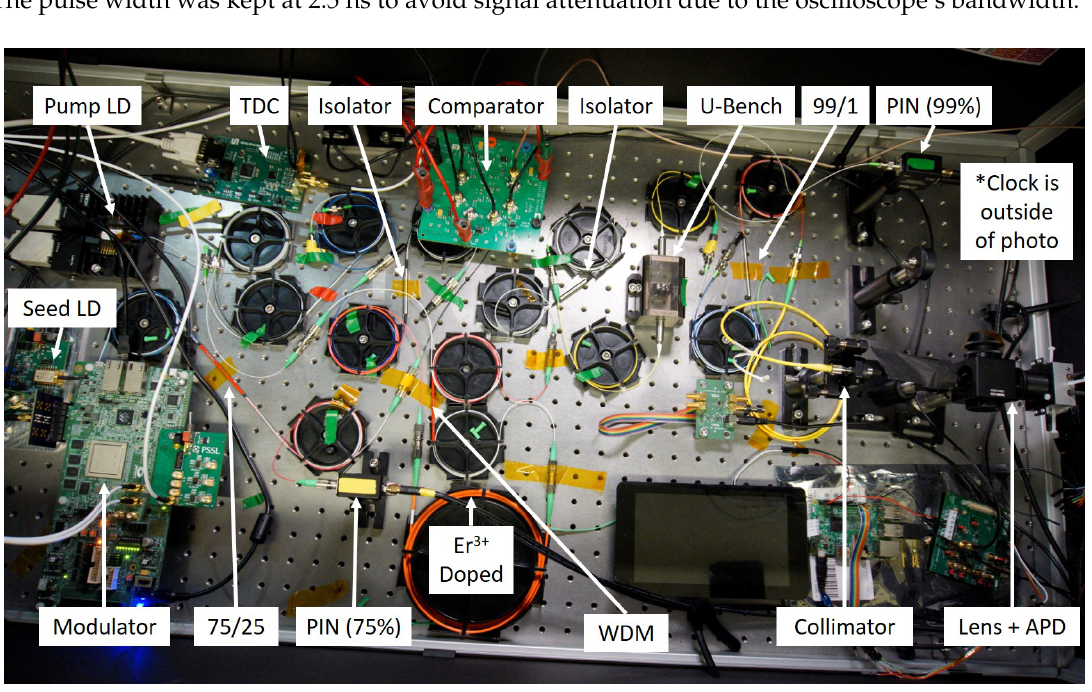
Figure 13. Photo of the end-to-end MOCT benchtop transceiver testing